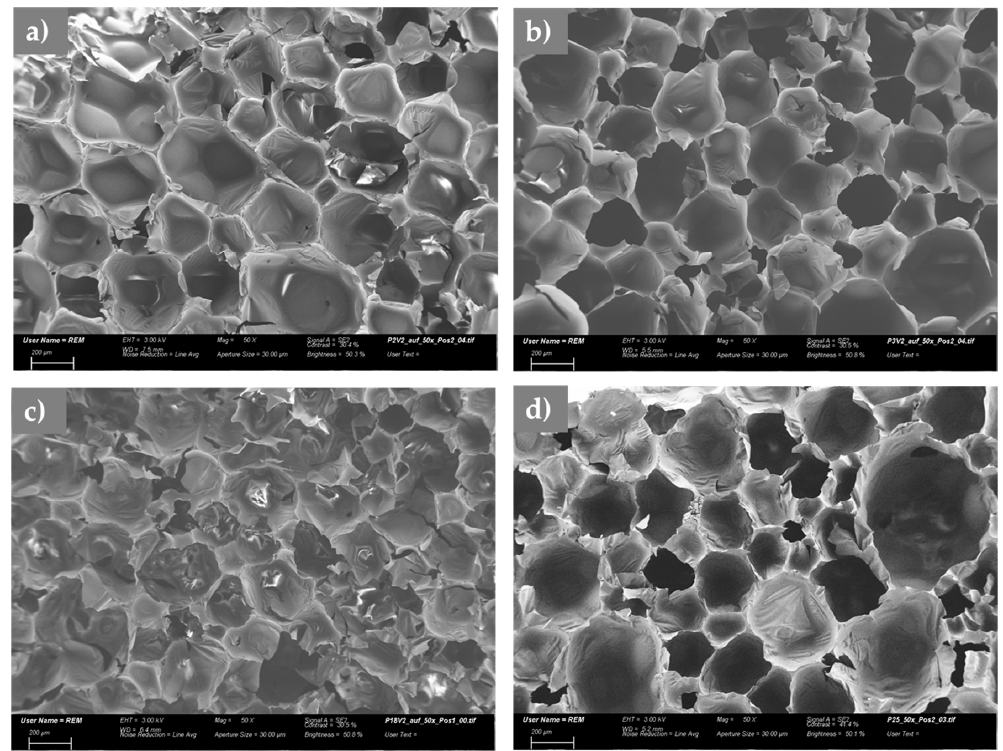
Figure 3. Examples of SEM images of foam ( a ) TEP-0.3%P; ( b ) TPP/TEP-1.0%P; ( c ) Figure3. ExamplesofSEMimagesoffoam( a )TEP-0.3%P;( b )TPP / TEP-1.0%P;( c )MA-BPPO / TEP-1.0%P; MA-BPPO/TEP-1.0%P; and ( d ) AM-BPPO/TEP-1.3%P, scale bar: 200 μ m. and ( d ) AM-BPPO / TEP-1.3%P, scale bar: 200 µ m.